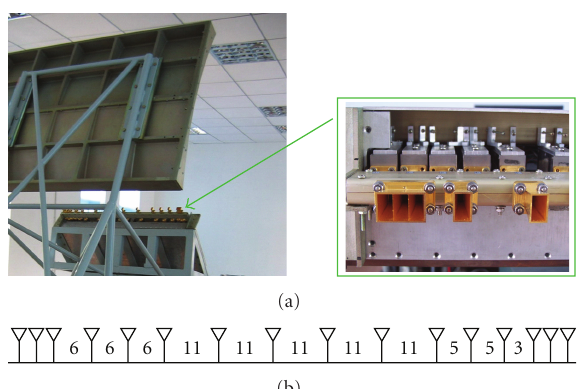
Figure 2: The HUST-ASR antenna array; (a) the photo of the whole antenna and the partial feed array; (b) a 16-element minimum redundancy linear feed array which can simultaneously measure visibility at 91 contiguous spacings (including zero spacing) with just 16 antennas. According to this arrangement, a conjoined triple- horn structure has to be used at each end of the array because of the very close spacings which contribute much to the mutual